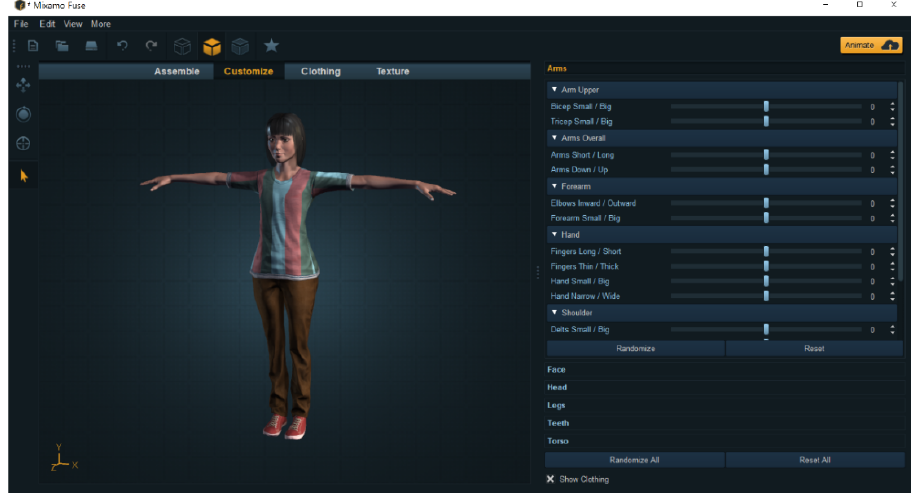
Figure 4. The Fuse CC user interface. The different model creation categories are shown above: Assemble (choose body parts), Customize (use sliders to adjust body features), Clothing, and Texture.